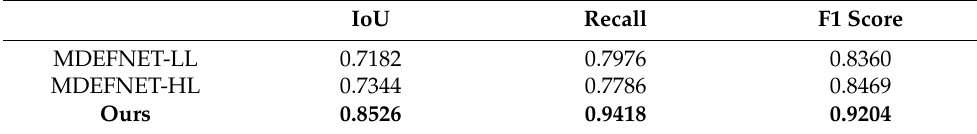
Table 3. The evaluation metrics results of ablation II experiments. IoU